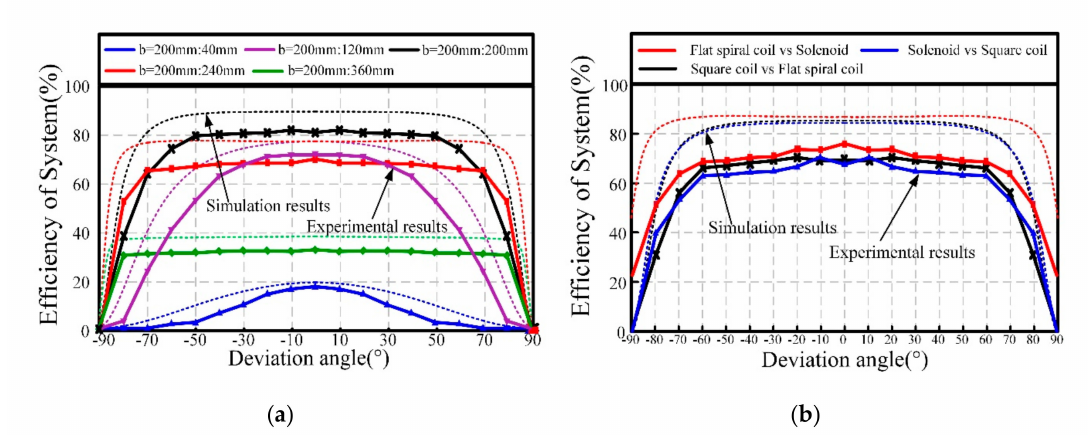
Figure 15. ( a ) System e ffi ciency vs. deviation angle at di ff erent radius ratios. ( b ) System e ffi ciency vs. deviation angle under di ff erent combinations of coil